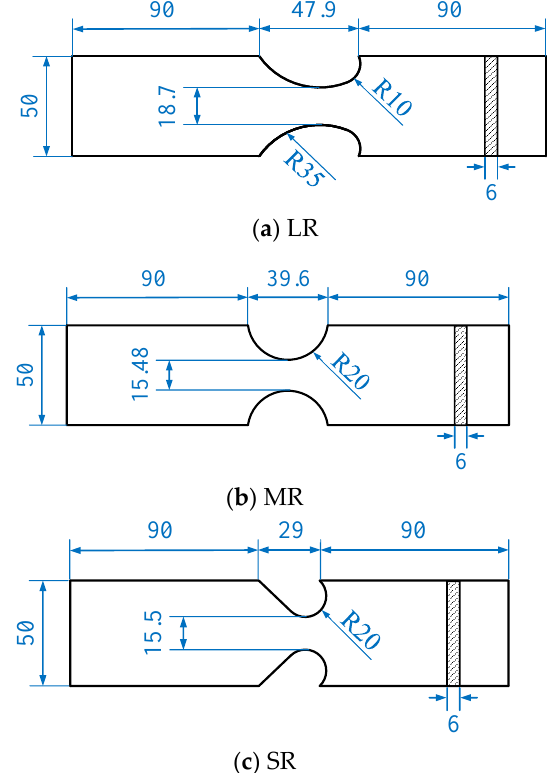
Figure 4. Geometries of three types of specimens (mm).